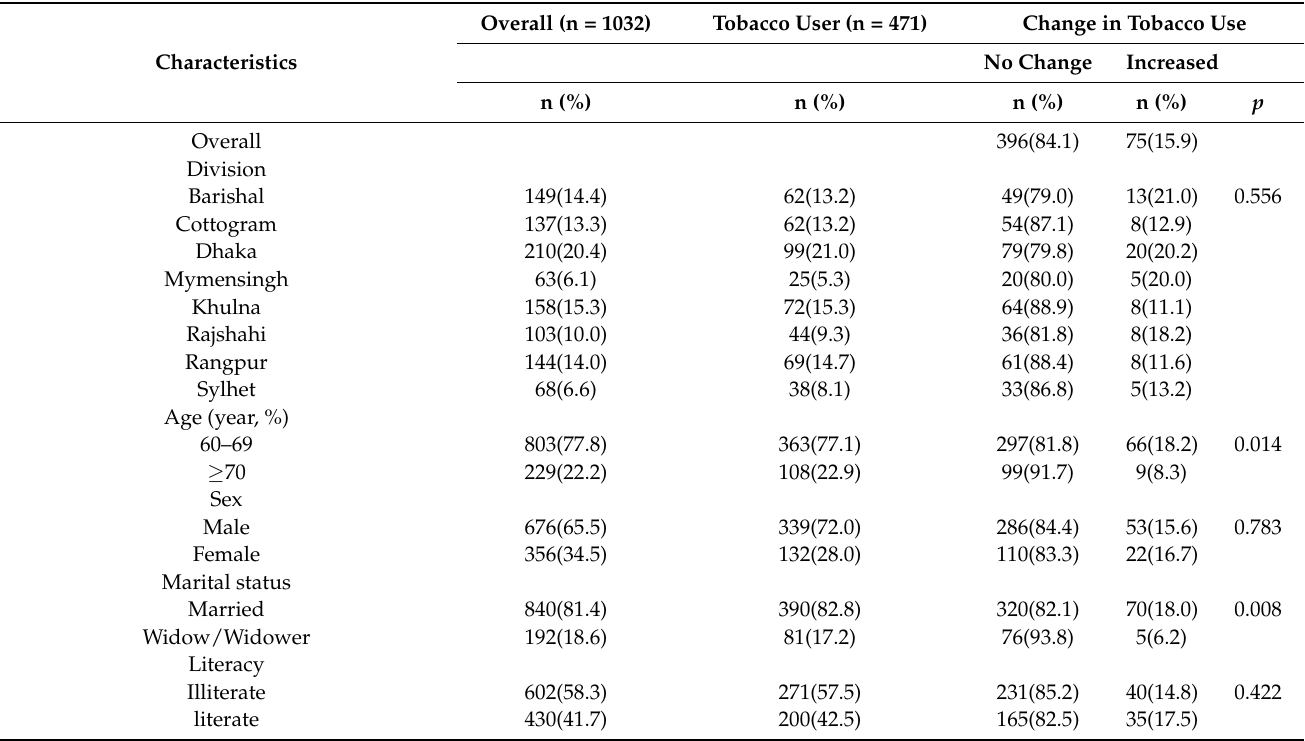
Table 1. Participants’ characteristics and bivariate analysis of changes in tobacco use during COVID-19.